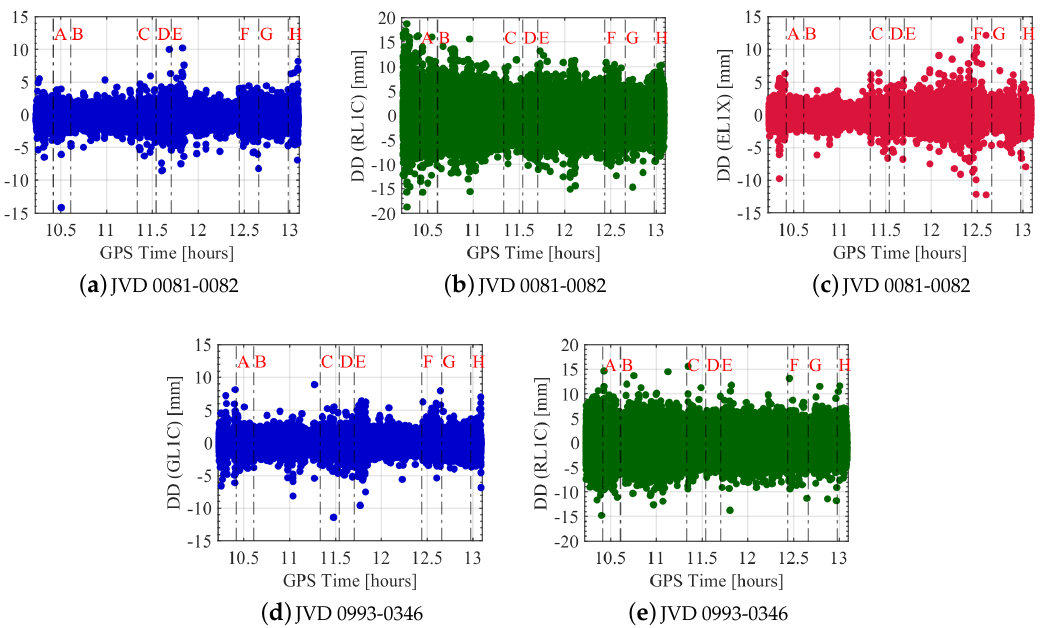
Figure 13. DDs of L1 carrier phase observations from all satellites for different receiver combinations with respect to the flight experiment time. GPS, GLONASS and Galileo noise levels are shown in blue, green and red colours, respectively. Black dashed vertical lines indicate different flight phases, which are explained in Table